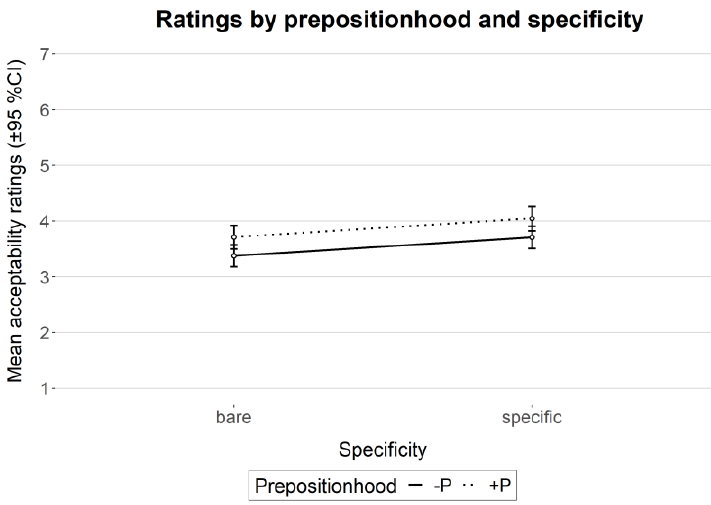
Figure 1. Mean acceptability ratings (n = 36). Error bars show 95% confidence interval. Table 1. Cumulative Link Mixed Model fitted with the Laplace approximation. Table 1. Cumulative Link Mixed Model fitted with the Laplace